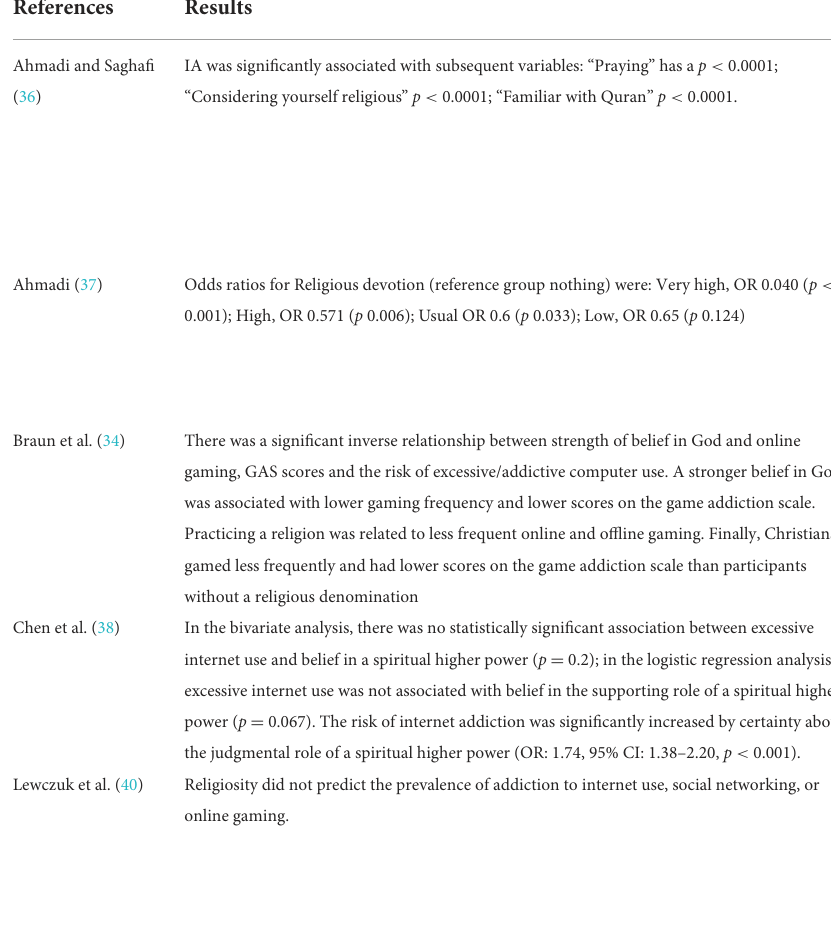
TABLE 2 Overview of study